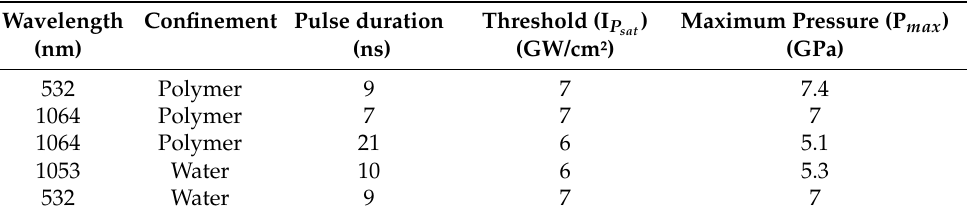
Table 3. Maximum pressure produced and breakdown thresholds of the polymer confinement for 532 and 1064 nm lasers for the different laser pulse duration used.